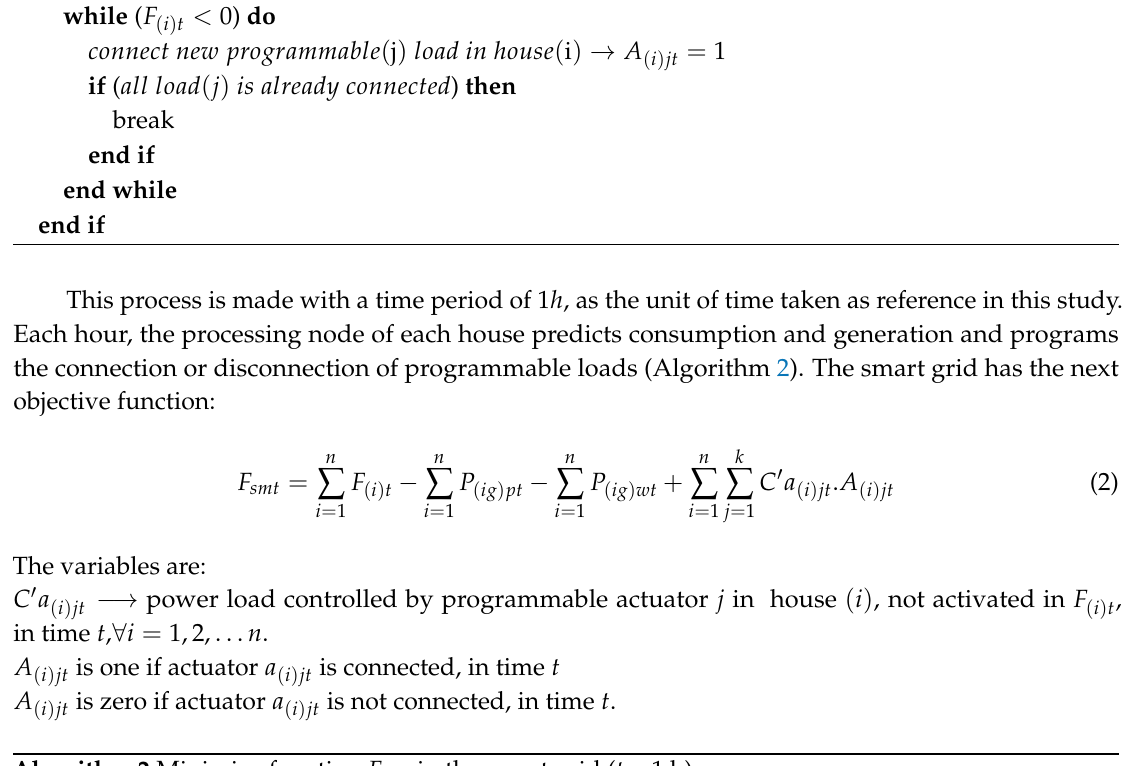
in house i (t = 1 h). i ) t